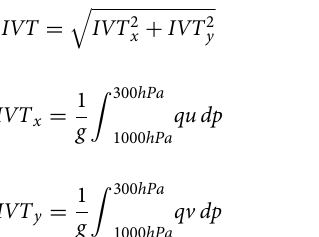
tively. Table S1 summarised all the information about the datasets employed. The integrated water vapour trans- port (IVT) intensity at each grid cell was calculated in an Eulerian framework 22,25,49